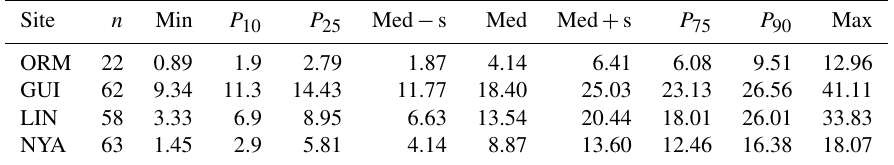
Figure 4. Results of the sample error model fit for the four sites studied (Eq. 18). The symbols and lines are the same than in Fig. 2a. Table 2. PWV statistics (mm) for the four sites: percentiles ( P xx ), median (med), minimum (min), maximum (max) and dispersion (s). The dispersion has been estimated robustly by means of 1 . 4826 × MAD, where MAD is the median absolute deviation and 1 . 4826 is the scale factor between MAD and the standard deviation for perfect Gaussian